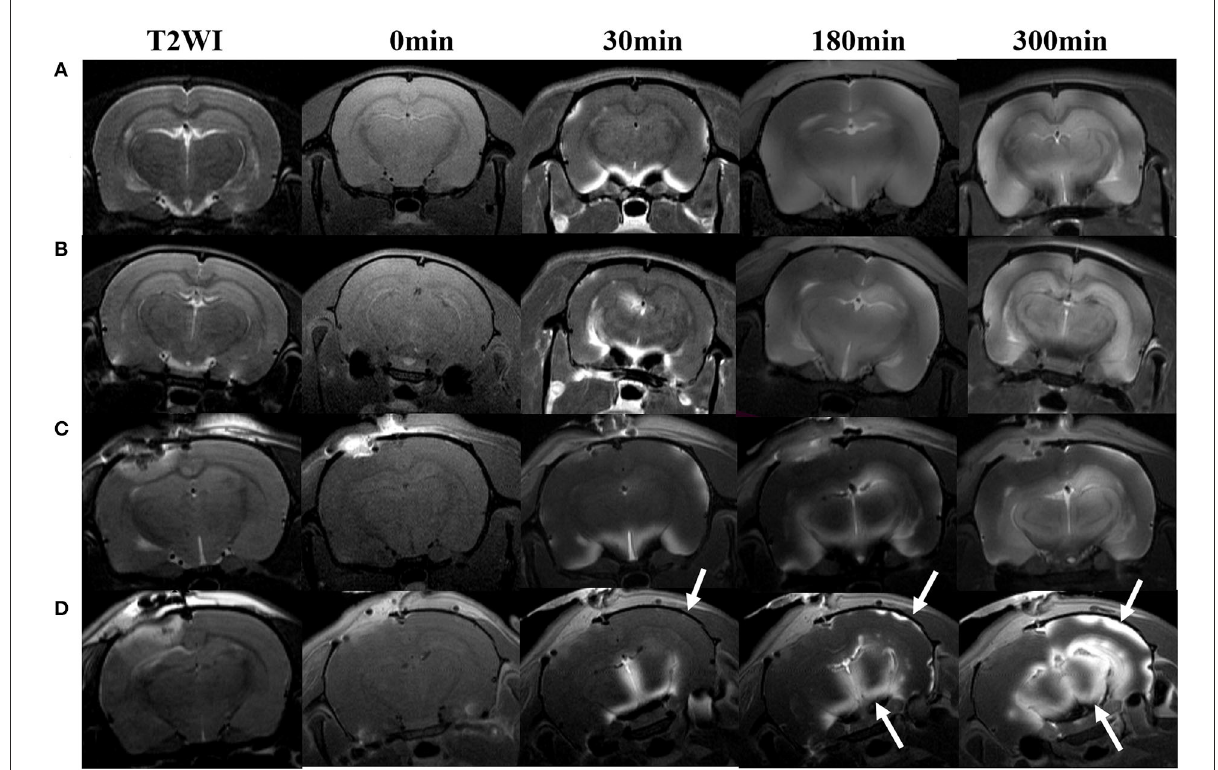
FIGURE6 Hypothermia-induced dynamic contrast concentration changes in traumatic and sham injury brain after intrathecal infusion of low molecular weight contrast agent Magnevist. The time series of coronal T1-weighted MRI images demonstrates early influx (0–30min), deep anatomic enhancement 180min, and 5h in subregion including bilateral cortex, bilateral hippocampus, and bilateral thalamus in Sham-NT (A) , Sham-HT (B) , TBI-NT (C) , and TBI-HT (D) animal brains. Coronal T2WI is used as a reference to visualize brain subregions, such as the cortex, hippocampus, and thalamus on T1WIs. As indicated by arrows, therapeutic hypothermia leads to limited contrast agent diffused into the cortex at 30min, restricted to the superficial cortex and partial thalamus at 180min, and incompletely whole-brain infused at the end of the experiment (300min) after Gd-DTPA infusion in the brain of TBI-HT rat. Asymmetrical hemisphere distribution of contrast is detected in the injured brain of TBI-NT (C) and TBI-HT (D)